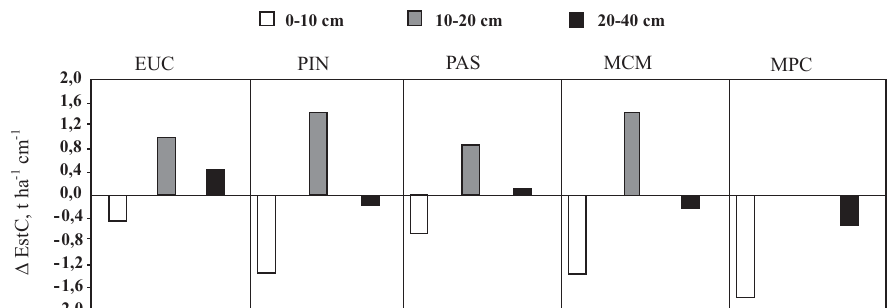
Figura 1. Variação do estoque de carbono orgânico ( ΔΔ ΔΔ Δ EstC) nas profundidades de 0–10, 10–20 e 20–40 cm em relação ao sistema mata nativa (MTN) num Latossolo Vermelho distroférrico típico submetido a diferentes sistemas de uso e manejo: EUC: eucalipto; PIN: pinus; PAS: pastagem; MCM: milho no sistema de cultivo mínimo; MPC: milho no sistema plantio convencional. Valores positivos indicam aumento no estoque de CO em relação ao sistema